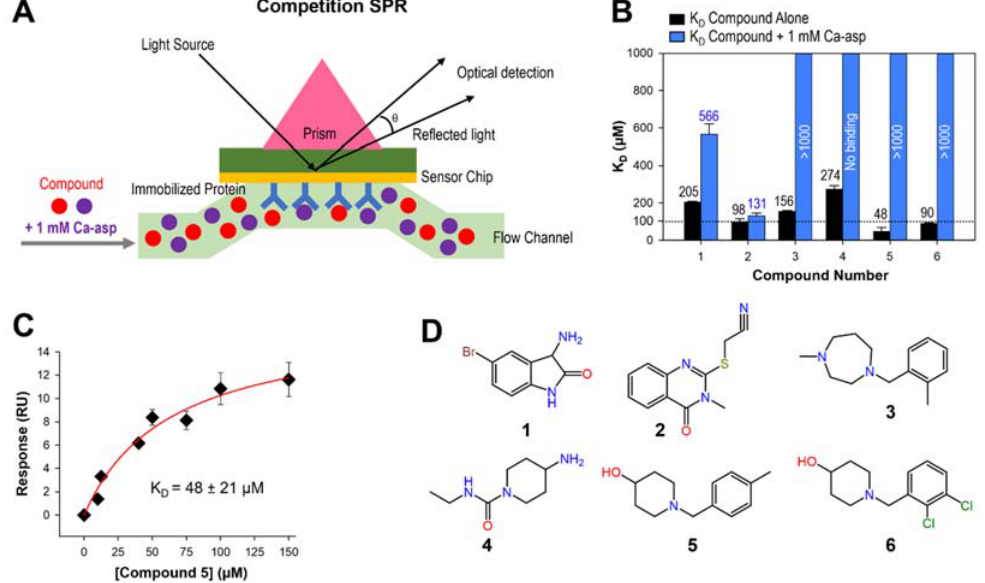
Figure 3. Binding affinity determination and catalytic site binders. ( A ) The schematic diagram of competition SPR with 1 mM substrate Ca-asp. ( B ) Bar graphs of the dissociation equilibrium constants ( K D ) value of 6 hit compounds. K D values were compared in the presence (orange) and absence (black) of 1 mM substrate Ca-asp as a competitor. Bars that reached the top of the graph represent K D values of >1000 µ M wherein the enzyme did not reach saturation, so K D was unable to be determined. ( C ) 1:1 Steady-state affinity fitting curve of the compound 5 . Determined K D value of compound 5 was 48 ± 21 µ M. ( D ) Chemical structures of six confirmed hit compounds.